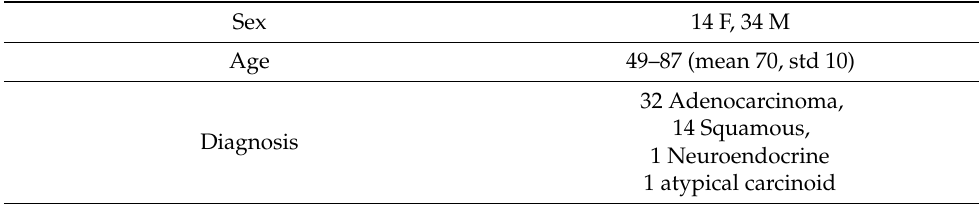
Table 2. Patient